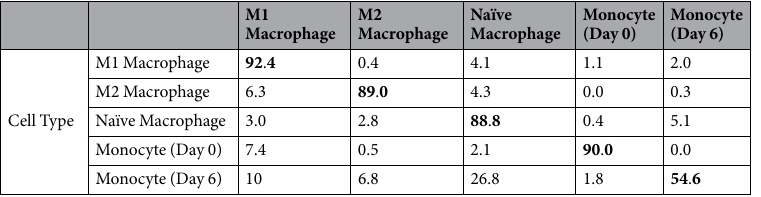
Table 3. Confusion matrix showing machine learning classification of immune cell phenotypes. Data is presented for all cells as a percentage of correctly classified cells. Approximately 500 observations were classified for each cell type across 152 images using a random forest classifier. The number of correctly classified cells is presented as a percentage, with true positives highlighted on the diagonal in red. Confusion matrices for all 5 classifier types used in this work are included in the supplementary